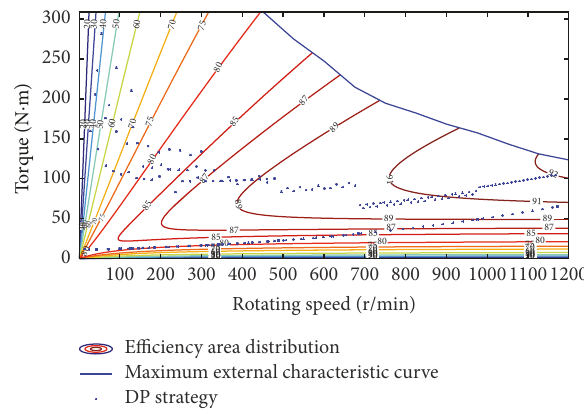
Figure 16: Distribution of motor working points under NEDC road condition.